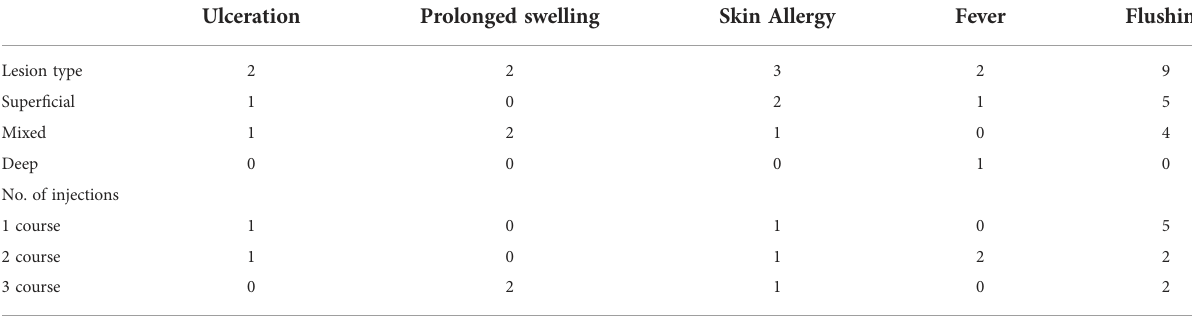
TABLE 2 Characteristics of 18 infantile hemangiomas patients with complications.